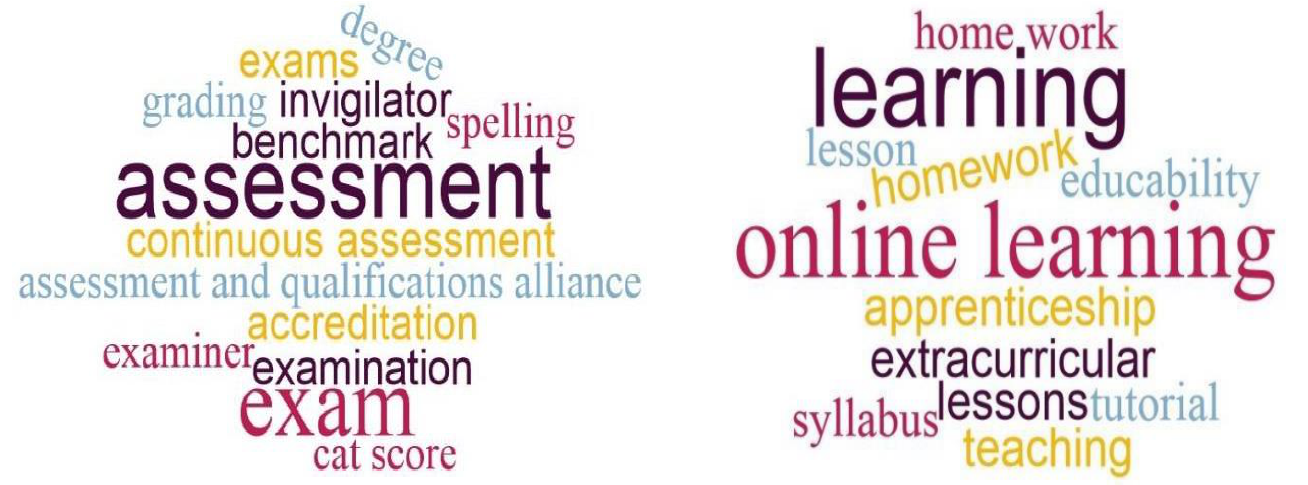
Figure 4. Vocabulary for learning ( right ) and assessment ( left ).